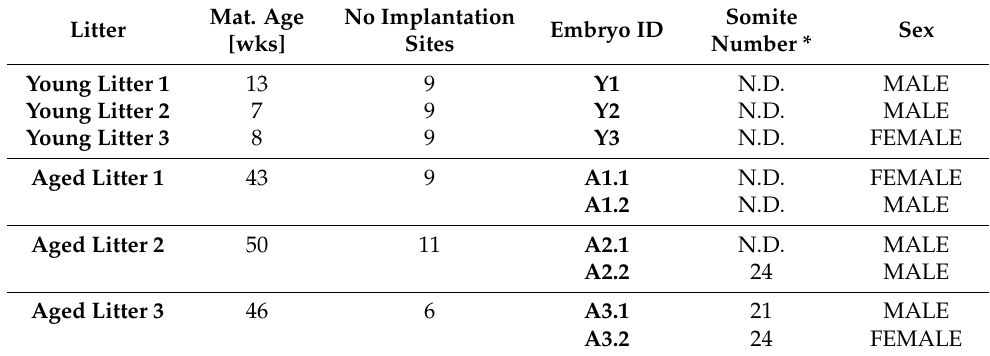
Table 1. Details of litters and embryos used. Mat. Litter